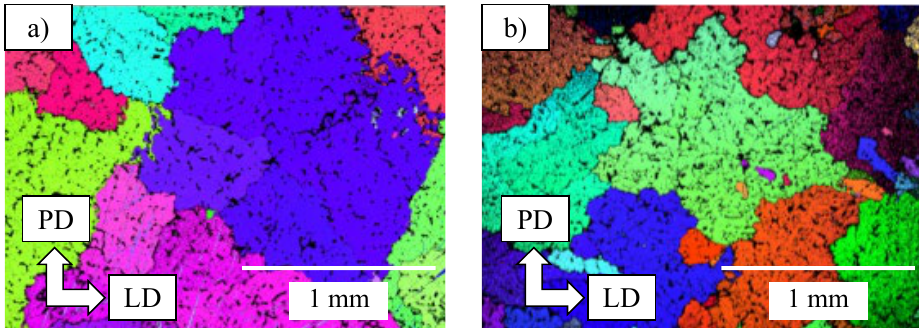
Figure 10. Cast alloys of ( a ) AZ91 and ( b ) AZ91–2Ca before the LFW process. Large grains and thick dendrite arms are observed.